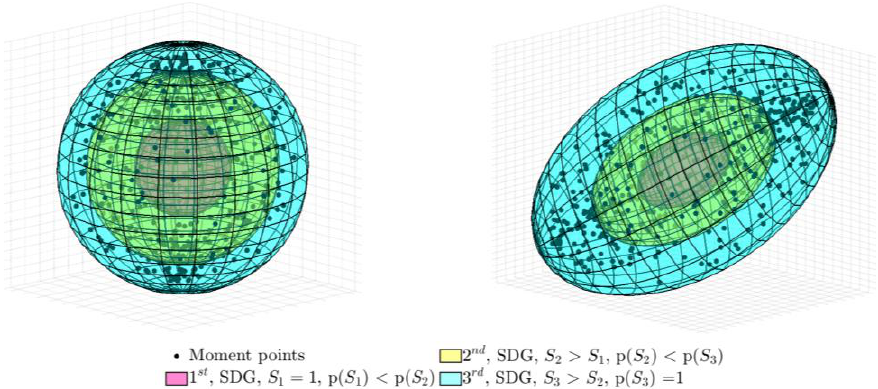
Figure 2. Visualization of standard deviation geometry scaling and corresponding confidence level.